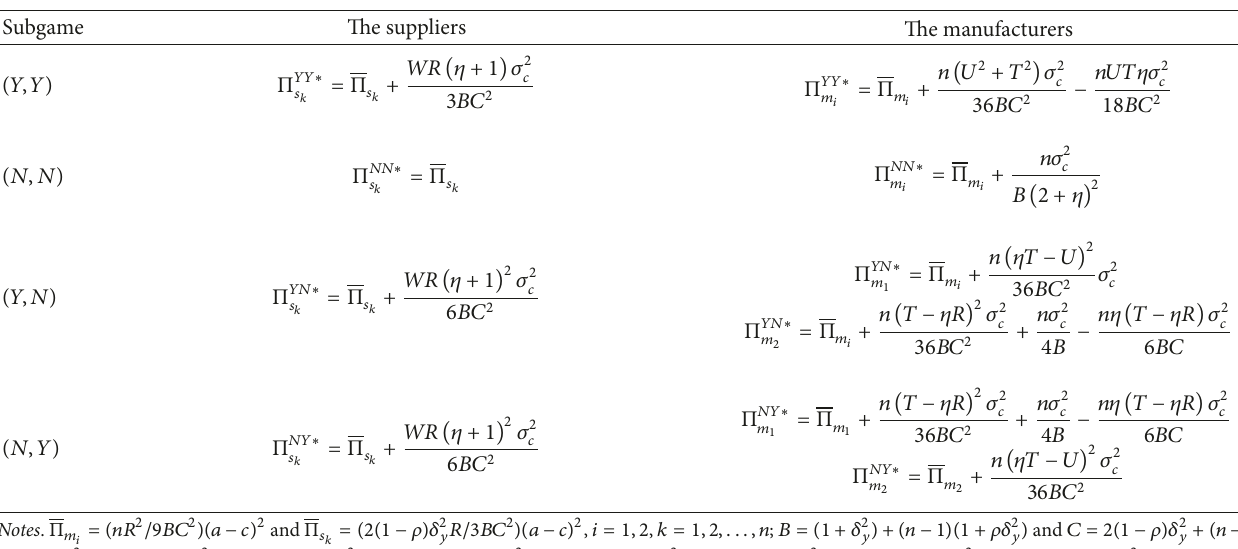
, 𝑉 𝑁 𝑚 , 𝑉 𝑁 𝑚 , 𝑉 𝑌 𝑠 , 𝑉 𝑌 𝑚 , and 𝑉 𝑌 𝑚 2 1 2 𝑘 𝑘